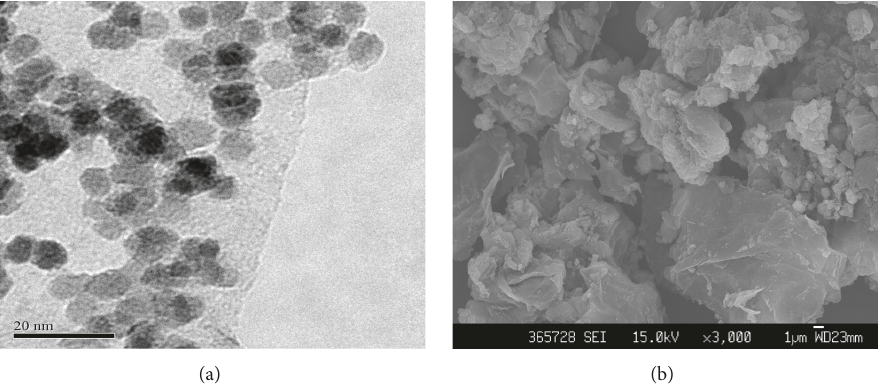
Figure 2: (a) TEM and (b) SEM images of G-Fe 3 O 4 composites.